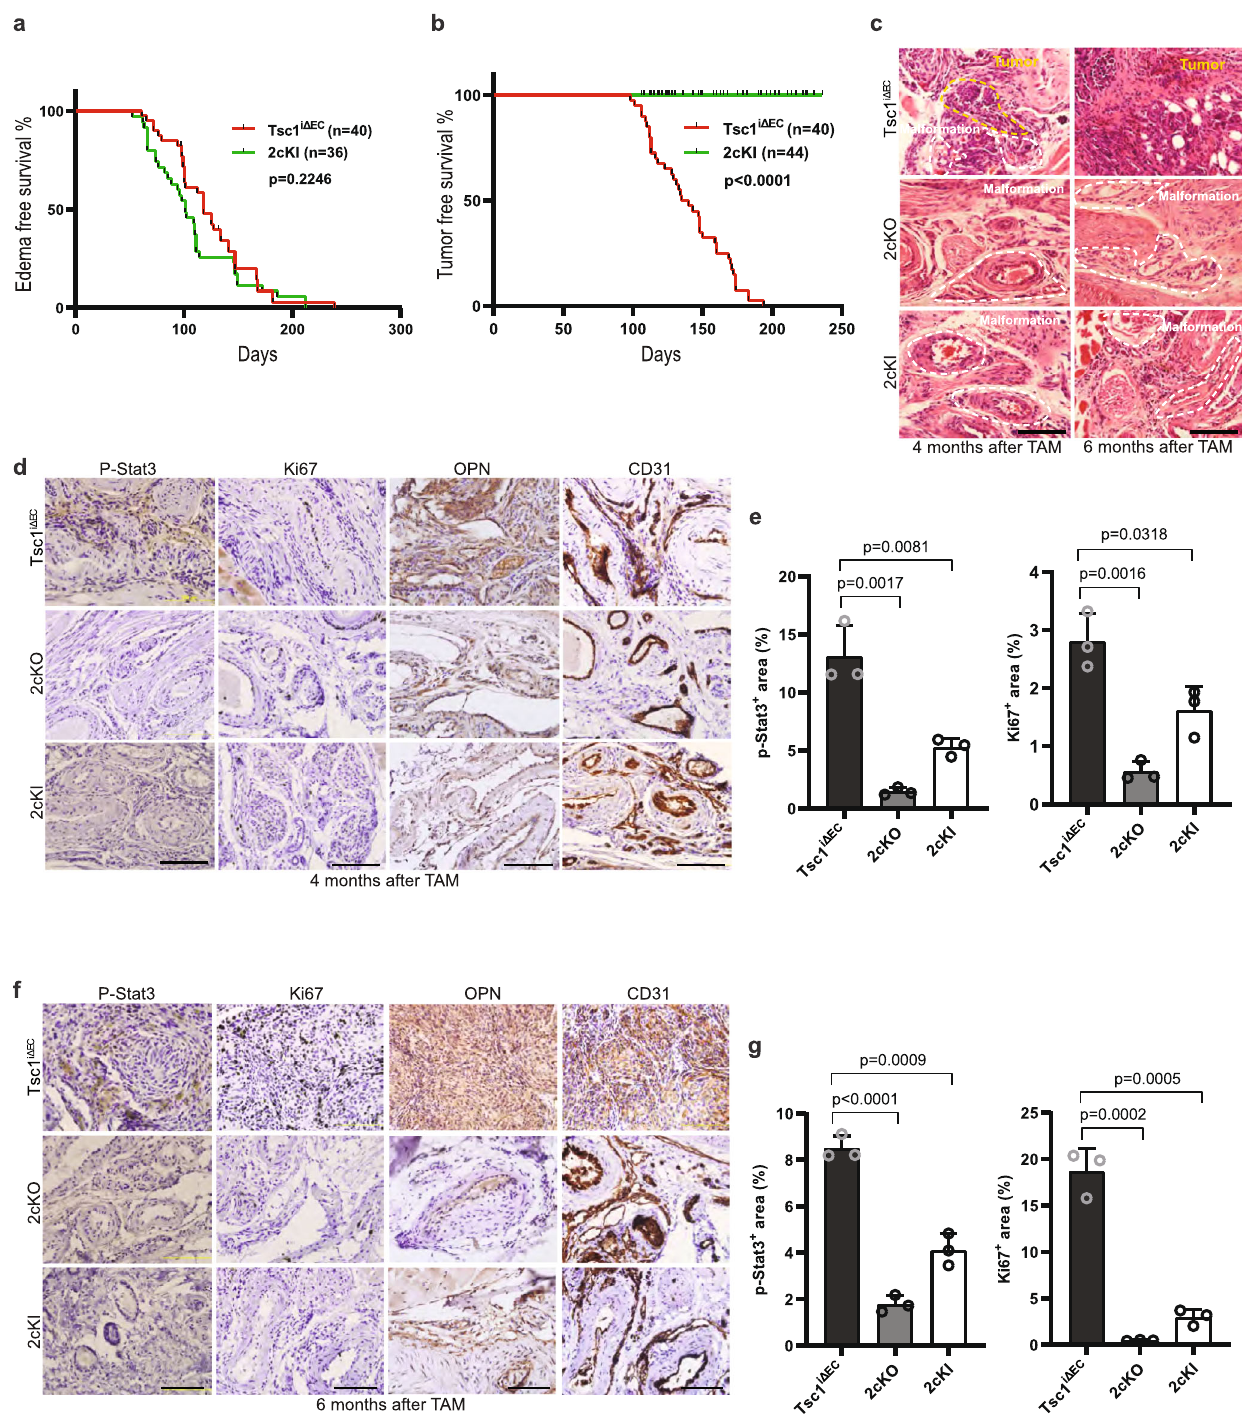
Fig. 7 | Speci fi c disruption of FIP200-mediated autophagy blocks LM pro- gression to LAS. a Kaplan-Meier analysis of edema development for Tsc1 i Δ EC ( n =40) and 2cKI ( n =36) mice. Log-rank (Mantel – Cox) test, p =0.2246. b Kaplan- Meier analysis of LAS for Tsc1 i Δ EC ( n =40) and 2cKI ( n =44) mice. Log-rank (Mantel – Cox)test, p <0.0001. c Representative H&Estaining of vascularlesions of Tsc1 i Δ EC , 2cKO and 2cKI mice at 4 and 6 months after TAM. Scale bar, 100 µ m. d , e IHC for P-Stat3, Ki67, OPN and CD31 of vascular lesions in Tsc1 i Δ EC , 2cKO and 2cKI mice at 4 months after TAM. Representative images ( d ) and quanti fi cation of